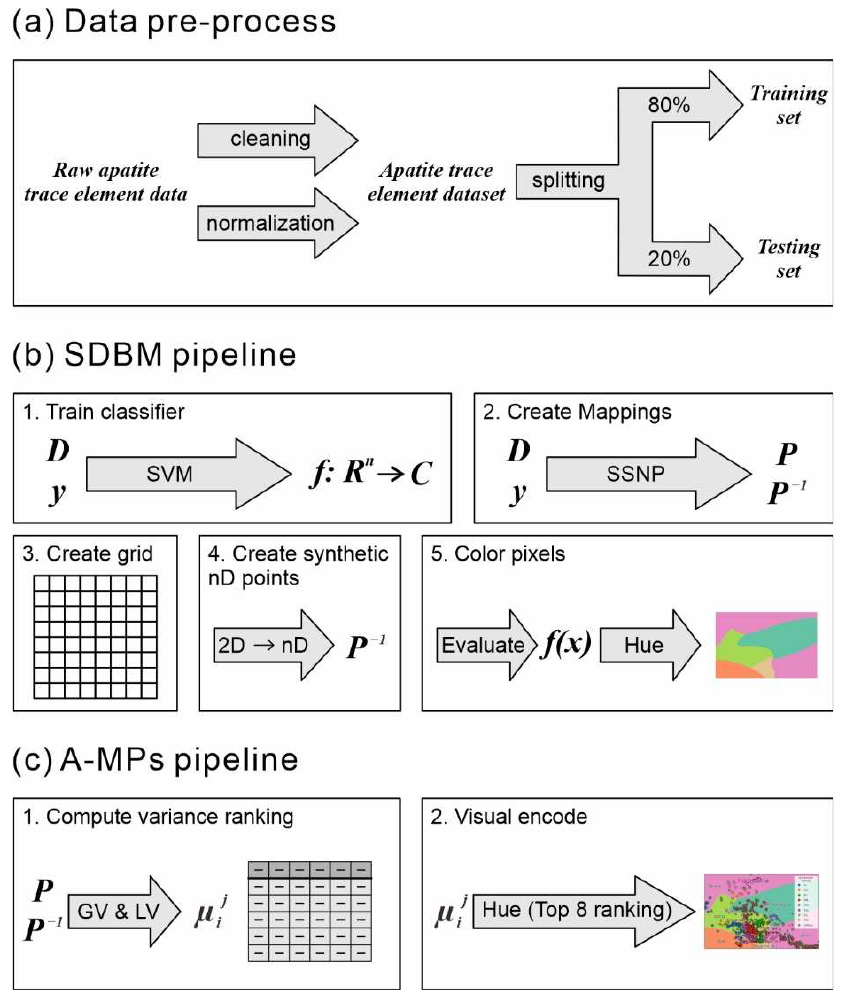
Figure 1. Data process workflow. ( a ) Data pre-process. ( b ) SDBM pipeline (after [18]). y is labels of the dataset as the genetic types of apatite. f ( x ) is evaluation metrics of accuracy and f1 score. The generated colored diagram is SDBM (The clear SDBM is shown in Figure 2. The remaining parameters are described in the text. ( c ) A-MPs pipeline. The generated colored diagram is visual encoding of A-MPs (The clear plot is shown in Figure